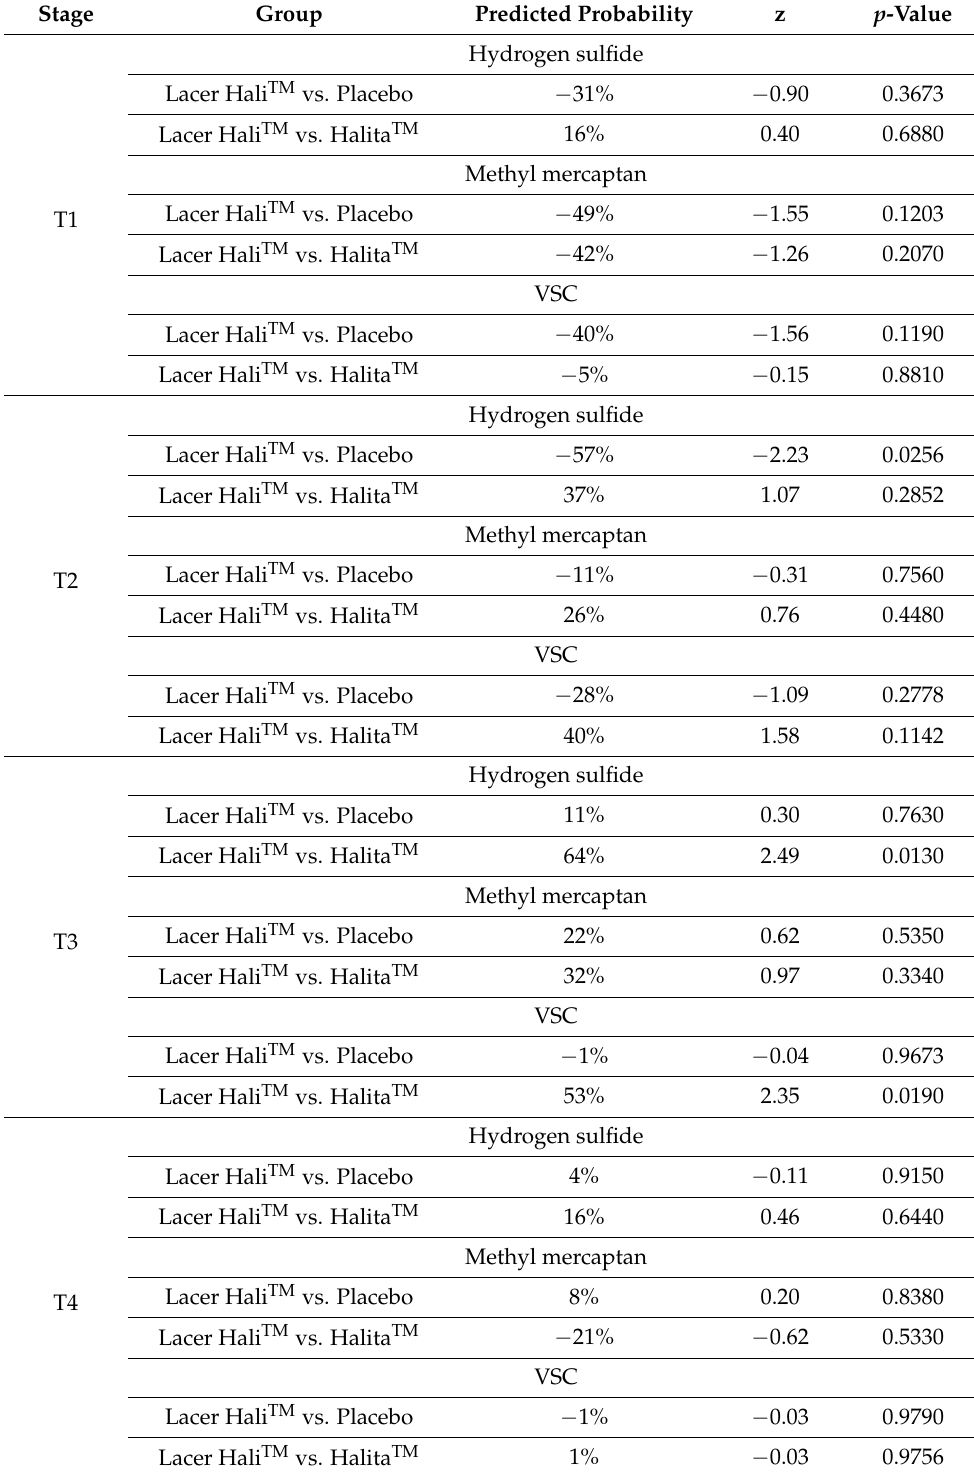
Table 4. Cont . Stage Group Predicted Probability z p -Value Hydrogen sulfide Lacer Hali TM vs. Placebo − 31% − 0.90 0.3673 Lacer Hali TM vs. Halita TM 16% 0.40 0.6880 Methyl mercaptan Lacer Hali TM vs. Placebo − 49% − 1.55 0.1203 T1 Lacer Hali TM vs. Halita TM − 42% − 1.26 0.2070 VSC Lacer Hali TM vs. Placebo − 40% − 1.56 0.1190 Lacer Hali TM vs. Halita TM − 5% − 0.15 0.8810 Hydrogen sulfide Lacer Hali TM vs. Placebo − 57% − 2.23 0.0256 Lacer Hali TM vs. Halita TM 37% 1.07 0.2852 Methyl mercaptan Lacer Hali TM vs. Placebo − 11% − 0.31 0.7560 T2 Lacer Hali TM vs. Halita TM 26% 0.76 0.4480 VSC Lacer Hali TM vs. Placebo − 28% − 1.09 0.2778 Lacer Hali TM vs. Halita TM 40% 1.58 Hydrogen sulfide Lacer Hali TM vs. Placebo 11% 0.30 0.7630 Lacer Hali TM vs. Halita TM 64% 2.49 0.0130 Methyl mercaptan Lacer Hali TM vs. Placebo 22% 0.62 0.5350 T3 Lacer Hali TM vs. Halita TM 32% 0.97 0.3340 VSC Lacer Hali TM vs. Placebo − 1% − 0.04 0.9673 Lacer Hali TM vs. Halita TM 53% Hydrogen sulfide Lacer Hali TM vs. Placebo 4% − 0.11 0.9150 Lacer Hali TM vs. Halita TM 16% 0.46 0.6440 Methyl mercaptan Lacer Hali TM vs. Placebo 8% 0.20 0.8380 Lacer Hali TM vs. Halita TM − 21% − 0.62 0.5330 VSC Lacer Hali TM vs. Placebo − 1% − 0.03 0.9790 Lacer Hali TM vs. Halita TM 1% − 0.03